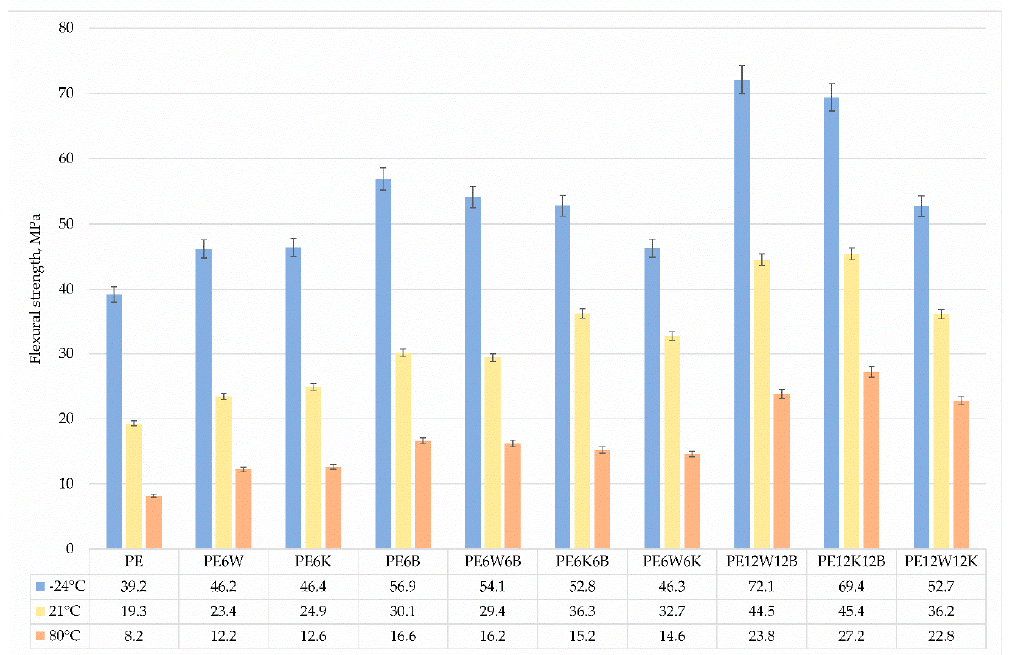
Figure 8. Comparison of flexural strength at three different temperatures.